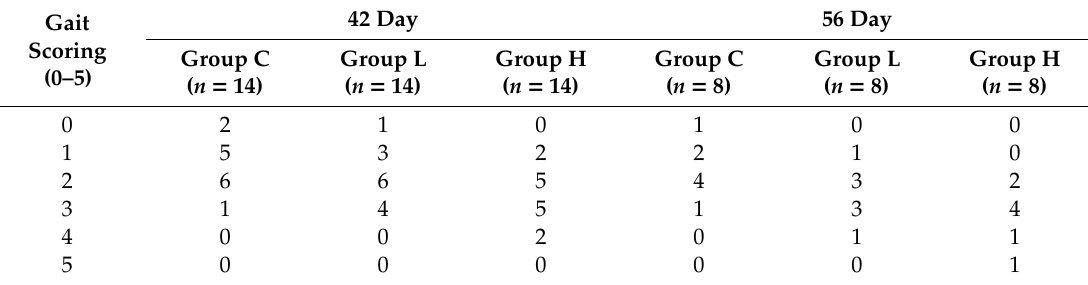
Table 1. The numbers of broilers with each gait score.